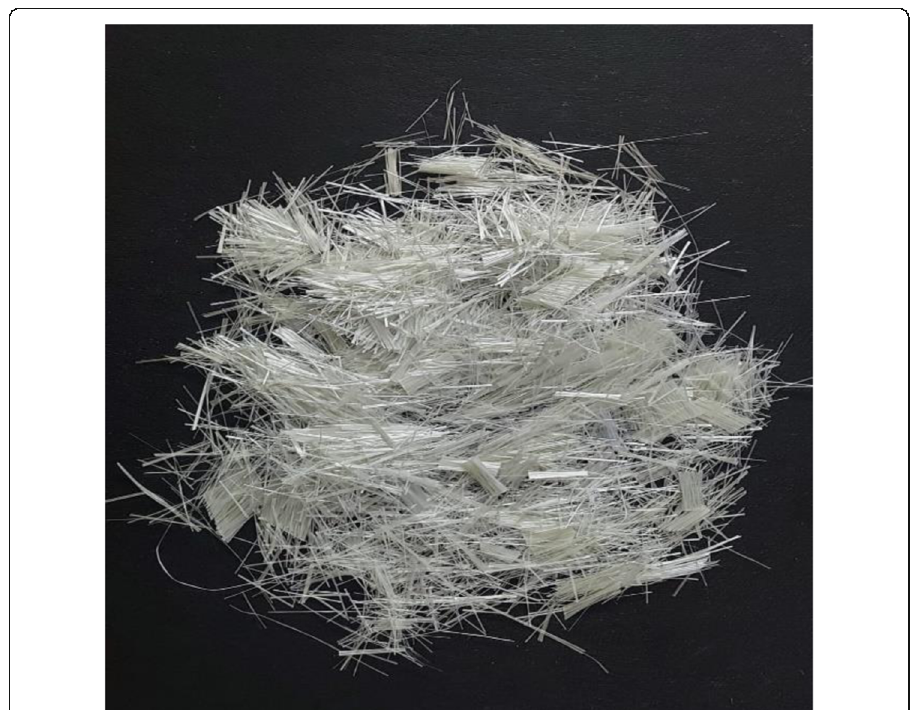
Fig. 2 Short glass fiber reinforced